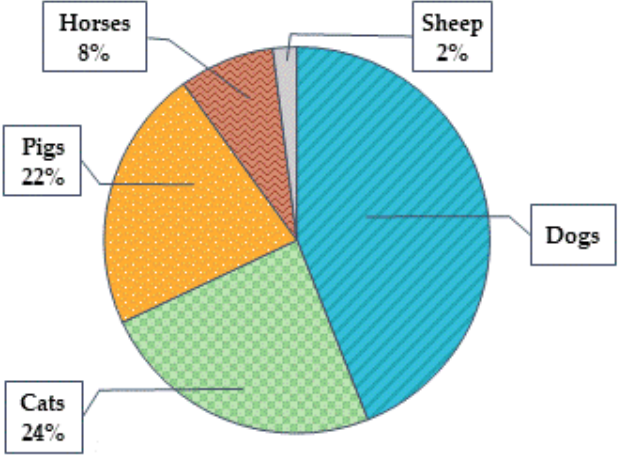
Figure 3. Percentage of the participants with the maximum valence induced by different animal species.